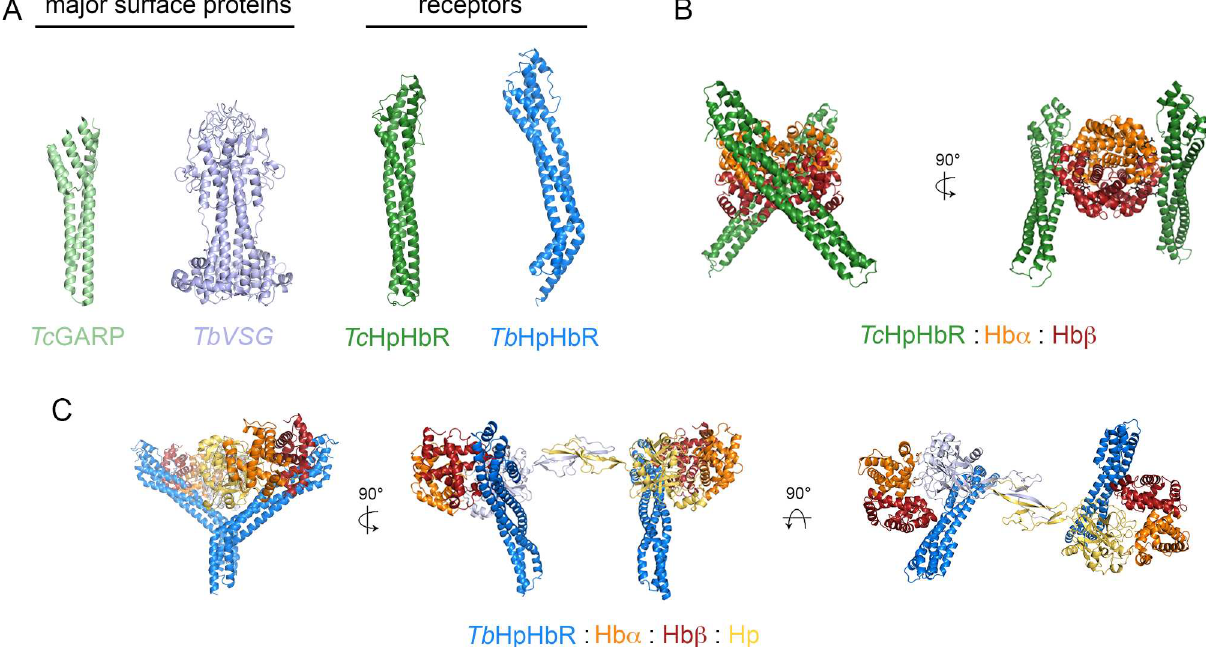
Fig 1. The structures of trypanosome surfaceproteins. A. The structures of the major surface proteinsof the T . congolense epimastigote, the glutamicacid rich protein(GARP) and of the T . brucei bloodstream form, the variantsurface glycoprotein (VSG), and the structures of the T . brucei and T . congolense haptoglobin–hemoglobin receptors(TbHpHbRand TcHpHbR). Both TbHpHbRand TbVSG are elongatedby additionalC-terminal domains,which are not represented [10]. B. The structure of a complex of two TcHpHbRboundto a singlehemoglobin tetramer. The receptors are coupledto the cell membraneby a GPI anchor and willtilt in order to simultaneously bind to a singlehemoglobin. C. The structure of a complexof two TbHpHbRboundto a haptoglobin–hemoglobintetramer (silver and gold),showinghow the kink in the receptorallowstwo membrane-linked TbHpHbRto simultaneouslybind to a single